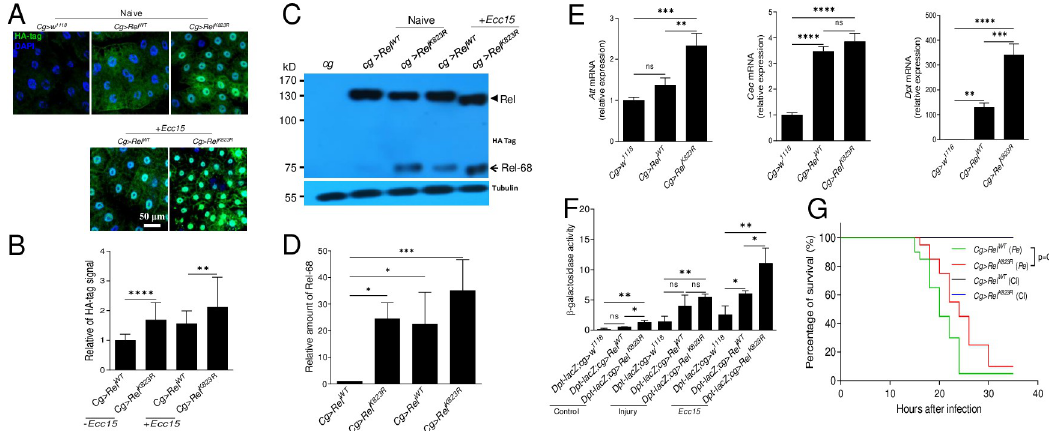
Fig 5. Loss of SUMOylation enhances Relish activation and AMP production in vivo . (A) Loss of the main potential SUMOylation amino acid enhances Relish nuclear translocation. HA-Rel WT –V5/His and HA-Rel K823R -V5/His (loss of SUMOylation) were over- expressed in fat bodies using the Cg-gal4 driver. Fat bodies dissected from na ï ve larvae and larvae (early 3rd instar) challenged with Ecc15 were immuno-stained using antibody against HA-tag. (B) Quantification of the HA-tag signal in the nuclei of fat bodies as shown in (A). For quantification, the HA-tag signal in the nuclei of Cg > w 1118 = 1. Data represent the average of at least three independent assays (mean ± SE). (C) Detection of active Rel-68 in the fat bodies. As shown in (A), Rel WT and Rel K823R were separately over-expressed in fat bodies using Cg-gal4. Antibody against the HA-tag was applied to detect Relish (arrowhead) and Rel-68 (arrow). Rel-68 is the transcriptionally active fragment after cleavage. (D) Quantification of the band density of Rel-68 shown in (C). This experiment was repeated four times. The amount of Rel-68 produced from fat bodies of Cg > Rel WT (- Ecc15 ) is equal to 1 for quantification. Mean values are presented ± SE. (E) qPCR analysis of AMP production in fat bodies with Rel WT or Rel K823R over- expressed in vivo . Data represent the average of at least three independent assays (mean ± SE). (F) The Dpt-lacZ reporter line was crossed with the indicated lines to over-express either Rel WT or Rel K823R in fat bodies. The above larvae (n = 20) were subjected to injury or Ecc15 immune challenge, then dissected at 6 h to obtain fat bodies for a β -galactosidase activity assay. Data represent the average of at least three independent assays (mean ± SE). (G) Survival analysis after Pseudomonas entomophila ( Pe ) infection. The injury of a clean injection (CI) is the control. A log-rank analysis on the Kaplan-Meier data showed a statistically significant difference in survival between larvae over-expressing Rel WT or Rel K823R in fat bodies. One way ANOVA with Tukey’s multiple comparisons test (E, D, F) or two-tailed Student’s t-test (B) was performed. � p < 0.05, �� p < 0.01, ��� p < 0.001, and ���� p < 0.0001. Bar: 50 μ